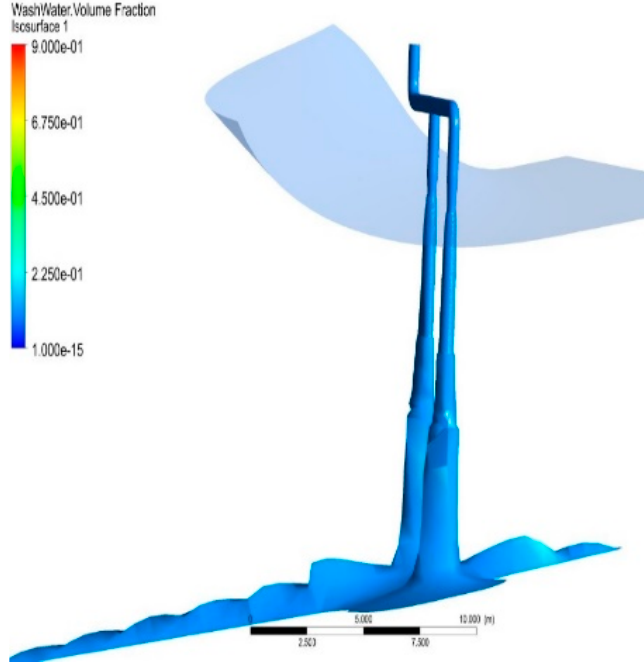
Figure 13. Scrubber Wash Water Volume Fraction of 0.1 isosurface development.